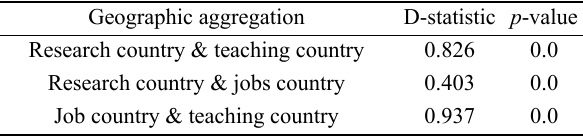
Table 2 KS test D-statistic value and p-value for similarity of distribution of differences at different aggregation